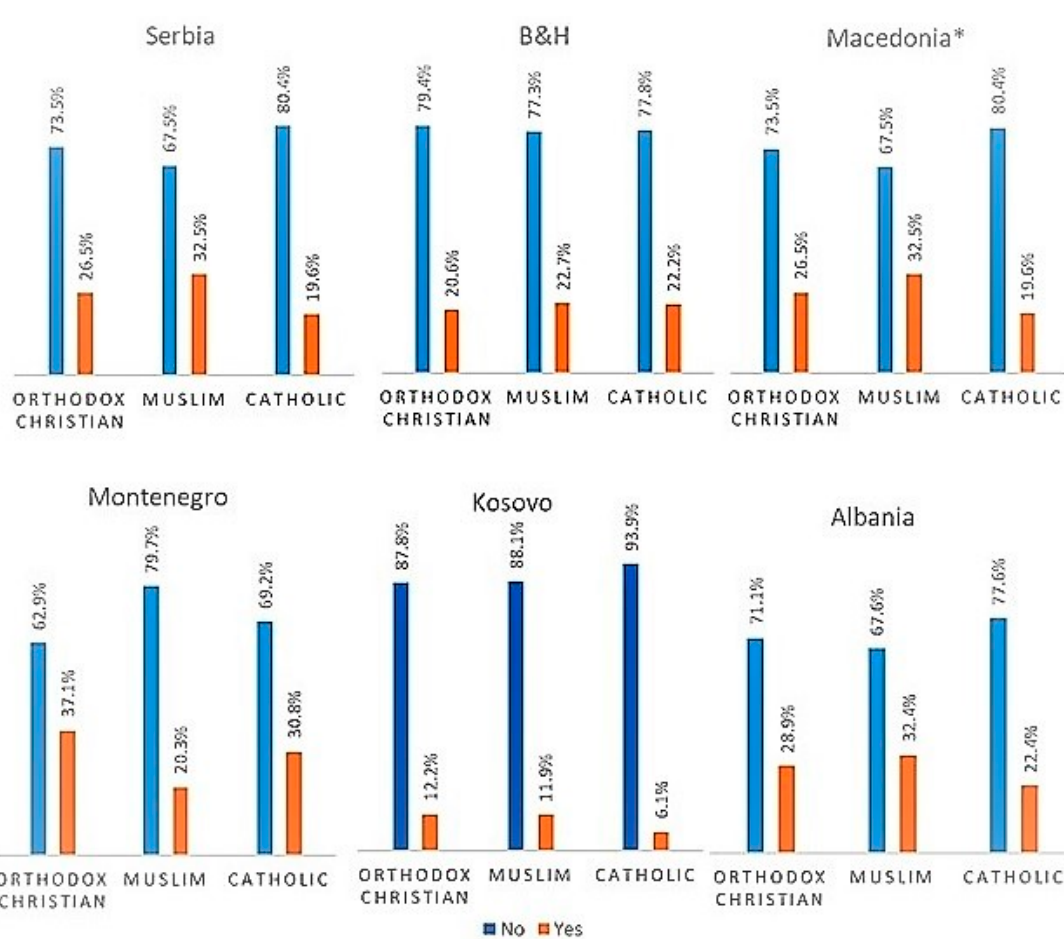
Figure 23. Confession and engaging in informal practices by country. Note: * Taking into account that the number of Catholics in Macedonia was extremely small, this category was excluded from the analysis.